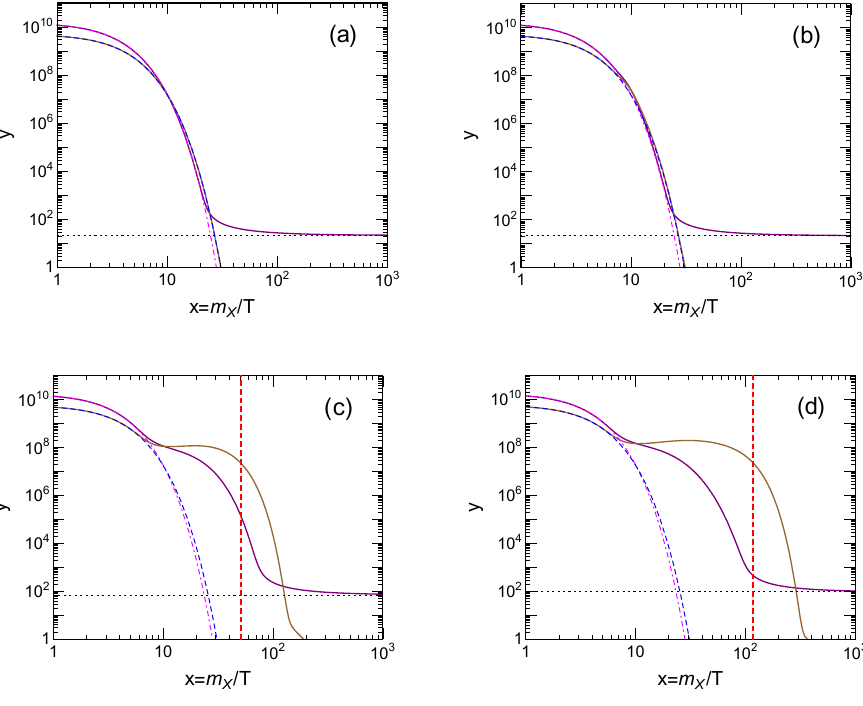
Figure 8 . Same as (cid:12)gure 7 but the 3 $ 2 interactions are included in the Boltzmann equations. In (a) and (b), the resulting x f is still to be 22, whereas in (c) and (d), the values of x f are 70 and 95, respectively. We show the same corresponding x (cid:0) as (cid:12)gure 7, for which the value is 51 in (c) and 117 in